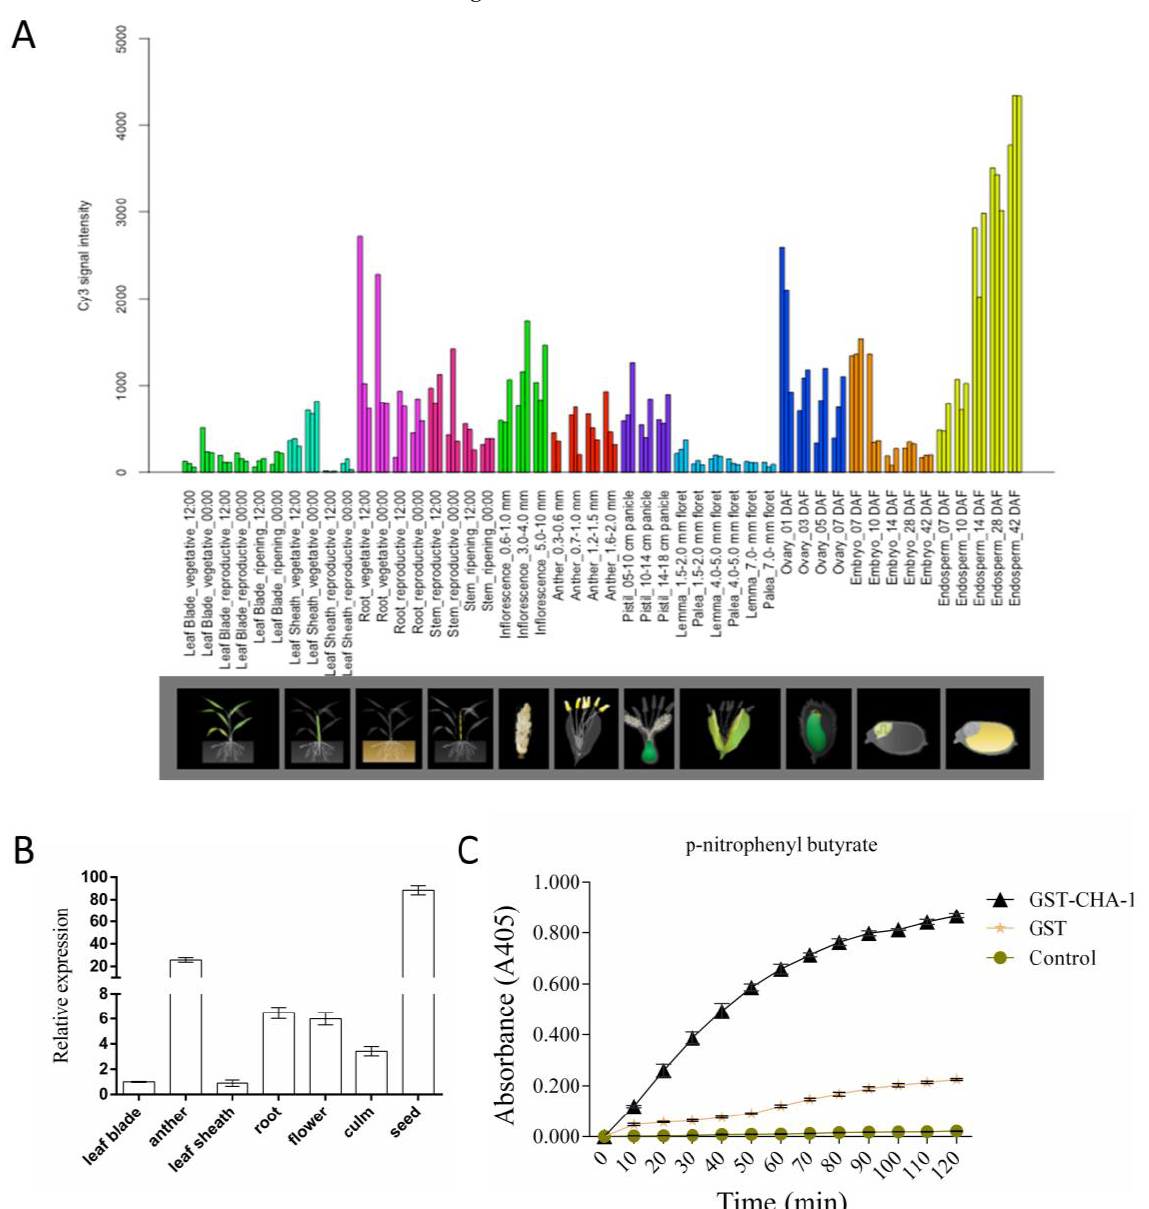
Figure 4. Expression analysis of CHA-1 . ( A ) Expression patterns of the candidate gene LOC_Os01g54810 . Gene expression profile data were obtained from the Rice Expression Profile (RiceXPro) database (http://ricexpro.dna.affrc.go.jp/, accessed on 20 February 2022). ( B ) Expression of the candidate gene LOC_Os01g54810 in various organs of rice. ( C ) Lipase activities of CHA-1 was incubated with p- nitrophenyl butyrate. Absorbance readings were collected every 10 min for 120 min. The substrates were incubated with GST-tagged protein and no protein as the GST and control,